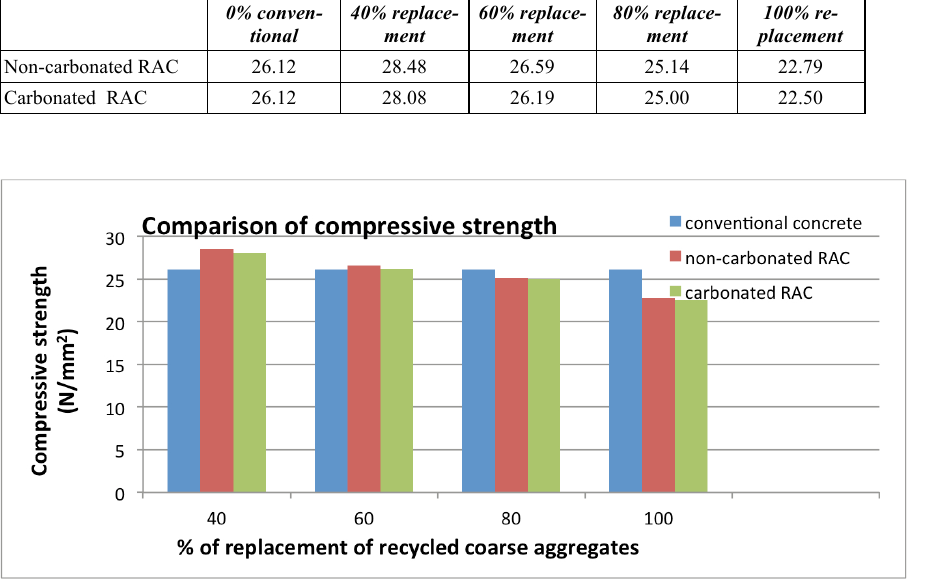
Fig. 6. Comparison of compressive strength of non-carbonated and non-carbonated RAC with